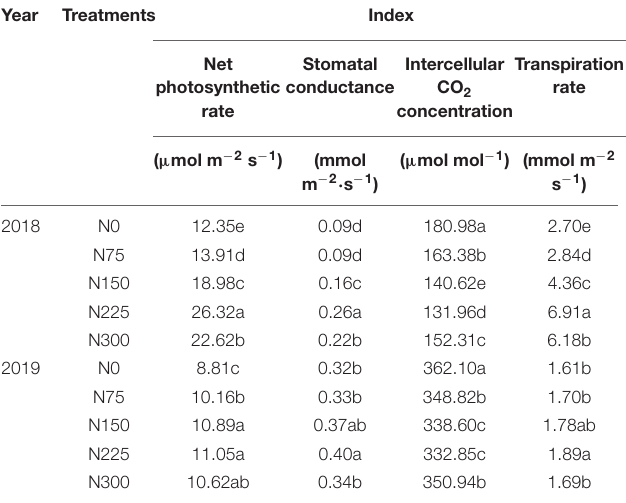
TABLE 2 | Effects of different N application rates on net photosynthetic rate, stomatal conductance, intercellular CO 2 concentration and transpiration rate at flowering stage of winter wheat in 2018 and